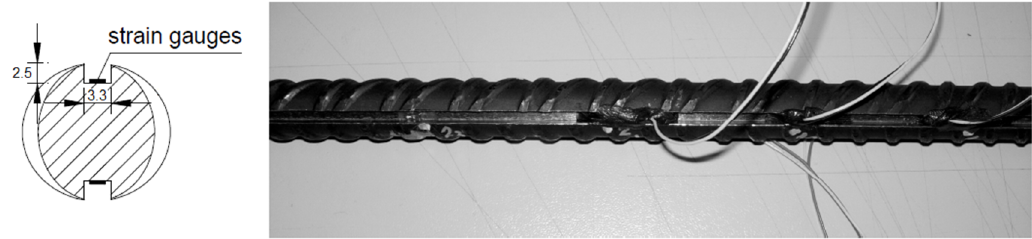
Figure 4. Insertion of electrical strain gauges in the ribbed steel rebar (unit: mm).